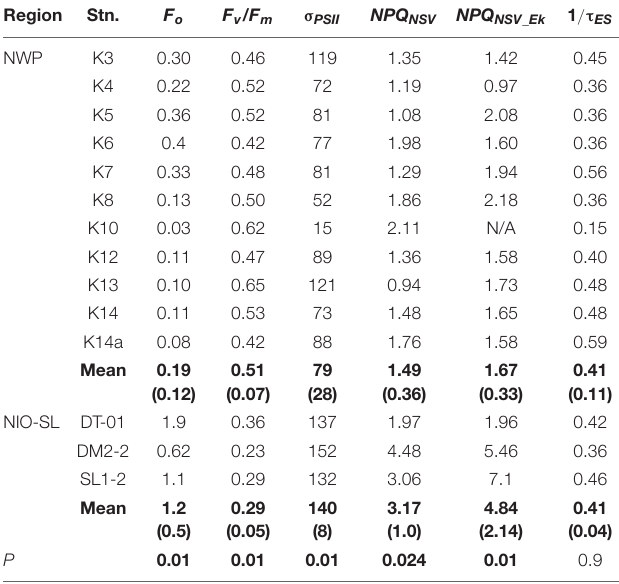
TABLE 3 | Value of photophysiological parameters, F o (arbitrary units: a.u.), F v / F m , σ PSII (Å 2 PSII − 1 ), NPQ at dark ( NPQ NSV ), NPQ at E k light ( NPQ NSV _ Ek ), and 1 / τ ES (ms − 1 ) at each sampling station measured by FRRf with combination band. Region